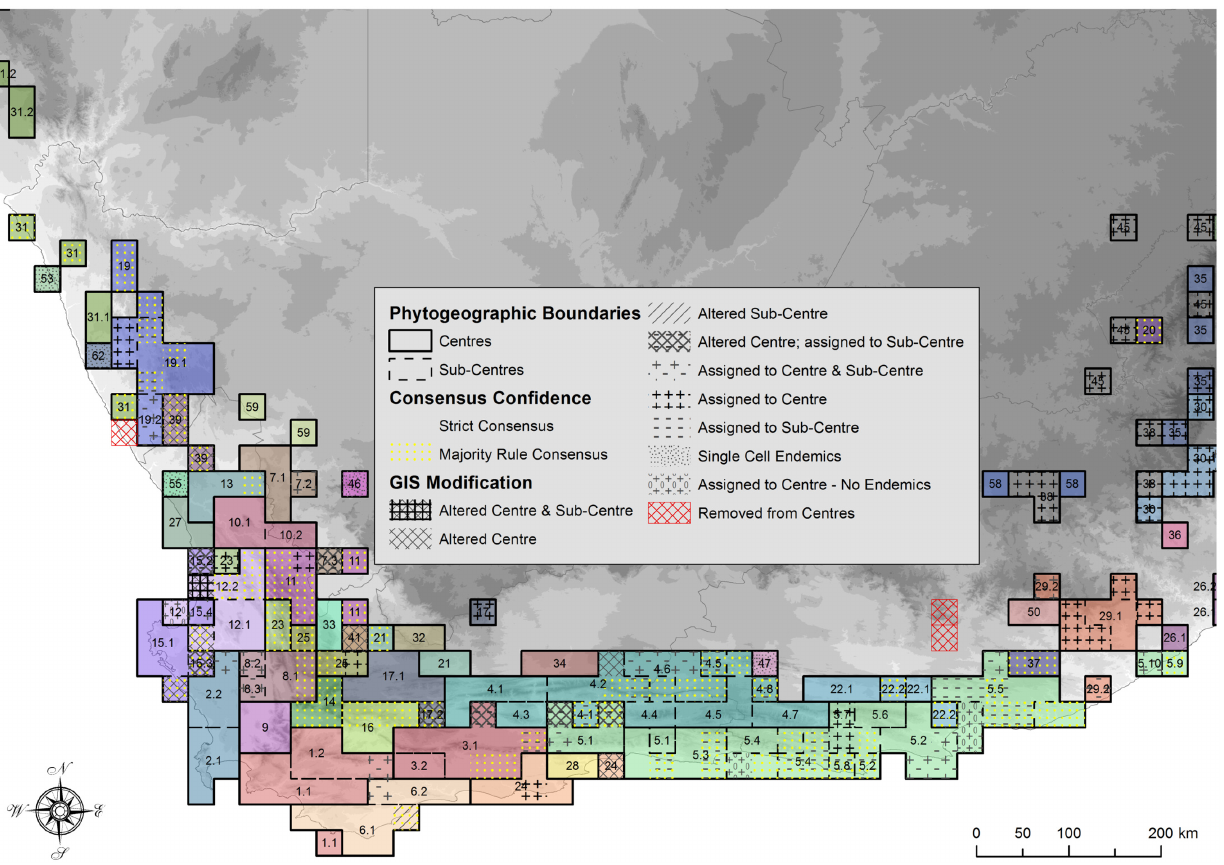
Fig 7. Spatial summary of the methods used for demarcating biogeographic areas. The relative robustness of the CoEs / Sub-CoEs identified in the CFR are indicated. The most robust CoEs / Sub-CoEs were retrieved by the strict consensus analysis (indicated without any patterning). These are followed in robustness by areas retrieved by the slightly less rigorous majority rule consensus (yellow dots). Post GIS modification then refined these initial candidates, altering cell assignment in CoEs (cross hatching) and Sub-CoEs (diagonal hatching). Cells not assigned due to conflict in clustering or consensus were then added to CoEs (+) or to Sub-CoEs (-), whereas single cell endemics that did not group with other cells were also indicated (fine dots). CoEs retrieved by clustering of taxa with very widespread distributions indicating uncertain collection effort were removed (red cross hatching). Finally, cells assigned to CoEs to bridge the gap between CoEs and BRs are indicated with +0, indicating no endemic taxa.